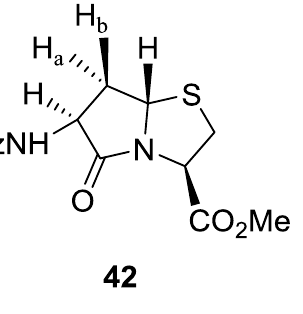
Figure 3. α and β diastereomers 42 and 43 .